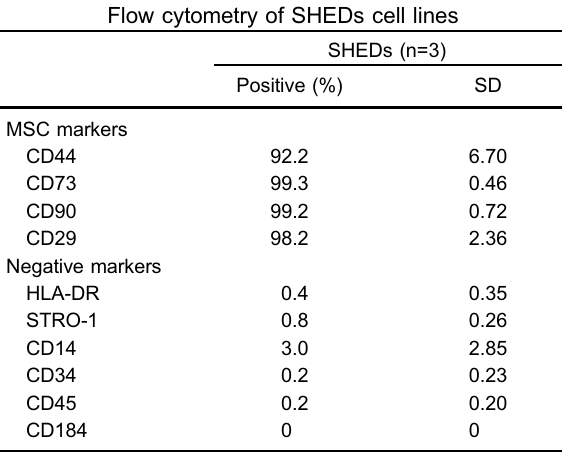
Table 1 . Characterization of stem cells from human exfoliated deciduous teeth (SHEDs) with mesenchymal stem cell markers using fl ow cytometry.